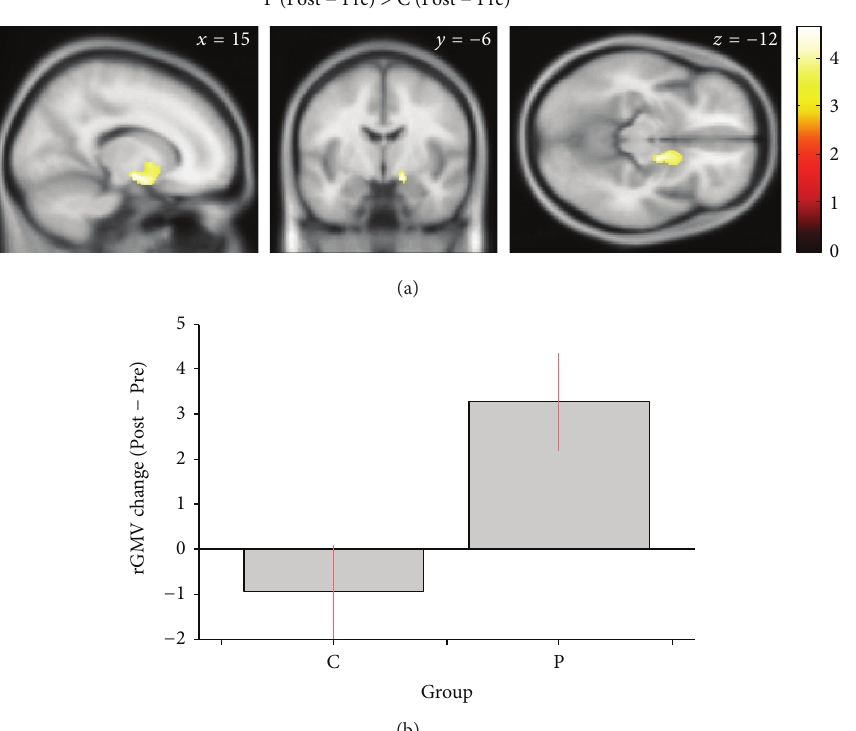
Figure 4: Significant between-group difference in regional gray matter volume (rGMV) changes. (a) In the structures around the right caudate, the rGMV changes were significantly different between Groups P and C. The colored cluster shows the region that exhibited significant differences in rGMV change with family-wise error corrected 𝑃 < 0.05 at the nonisotropic adjusted cluster level [59] with an underlying voxel level of 𝑃 < 0.001 . (b) The average of rGMV changes in each group shows that the differences in the region were largely because of the rGMV increases in Group P. The error bars in the graph show the 95% confidence intervals.